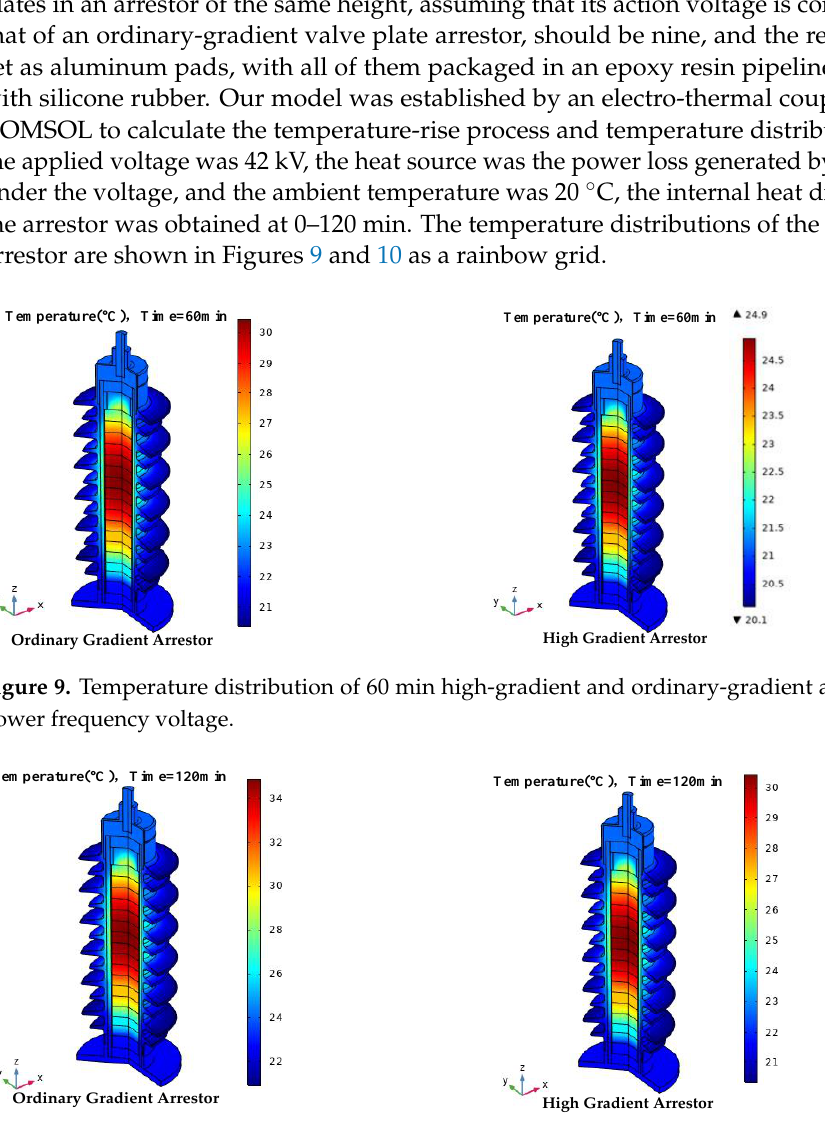
Figure 10. Temperature distribution of 120 min high-gradient and ordinary-gradient arrestor un- der power frequency voltage.